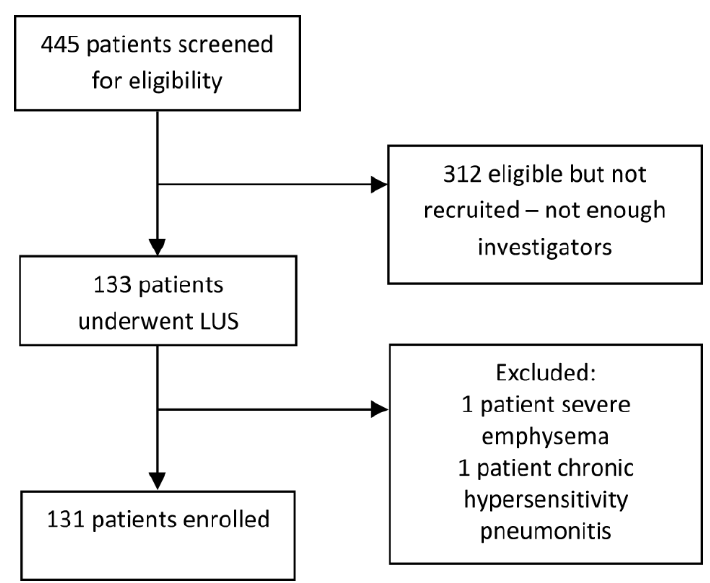
Figure 1. Flowchart of the included patients. The baseline characteristics of the included patients, including age, gender, day of illness, habits, comorbidities, and the respiratory support modality used, were comparable between the subgroups (Table